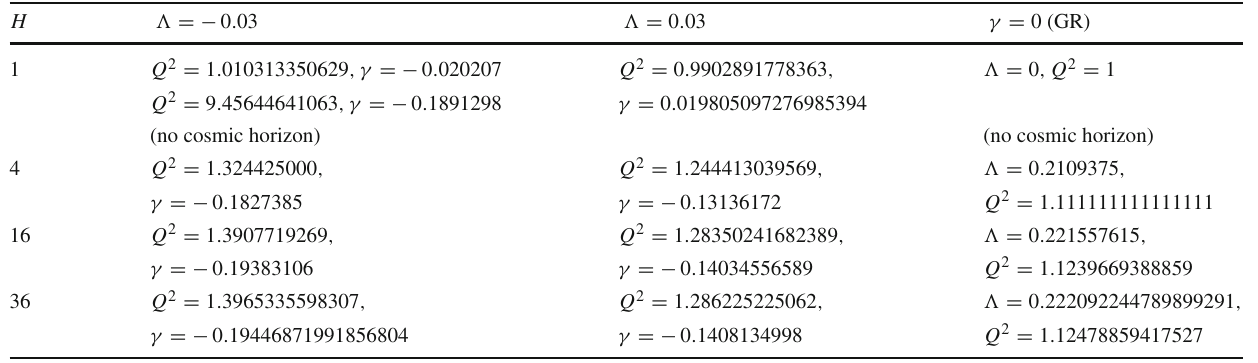
Table 3 Summary table of extremal BH parameters with potential CSCC violation for M = 1 , r H = r C , C 1 -SCC is always valid. Extremal AdS BHs and extremal RN BH at H = 1 have no cosmic